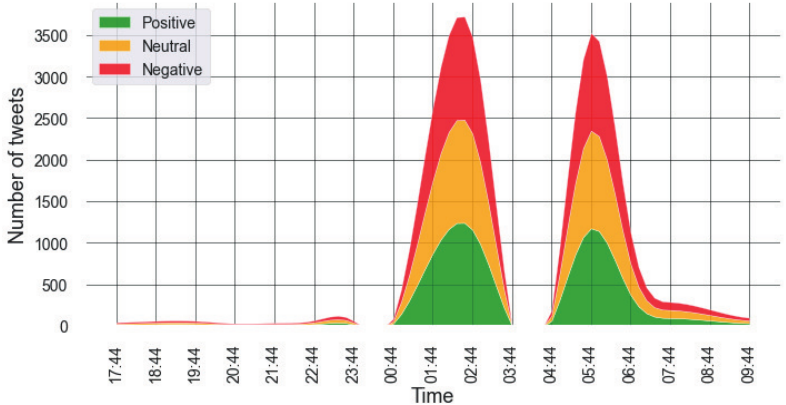
Figure 2. Distribution of positive, negative, and neutral tweets in the experimental dataset per hour. The tweets included in the plot are those annotated with a high confidence sentiment value.